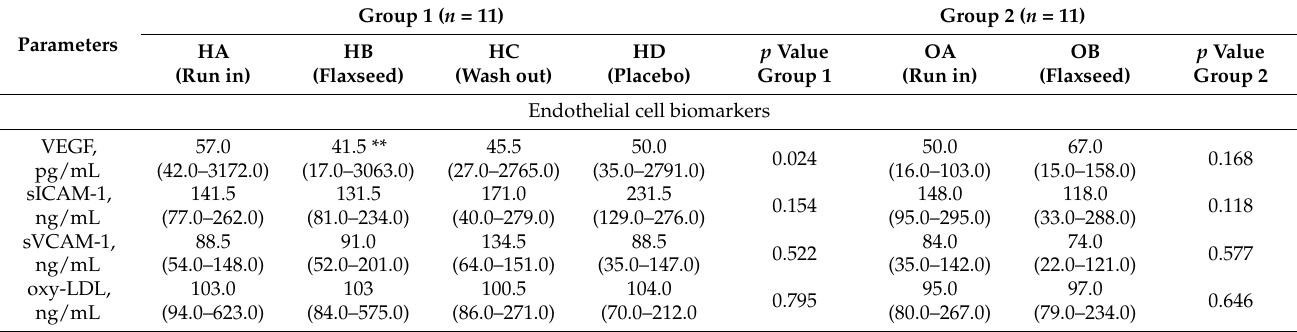
Table 2. Changes in endothelial parameters and oxy LDL throughout the study. The data are given as medians and range. Abbreviations: VEGF, vascular endothelial growth factor; sICAM, soluble intercellular adhesion molecule-1; sVCAM, soluble vascular cell adhesion molecule-1, oxy-LDL, oxy-low density lipoprotein cholesterol. The data were analysed with Friedman test with Dunn post hoc test. Wilcoxon signed-rank